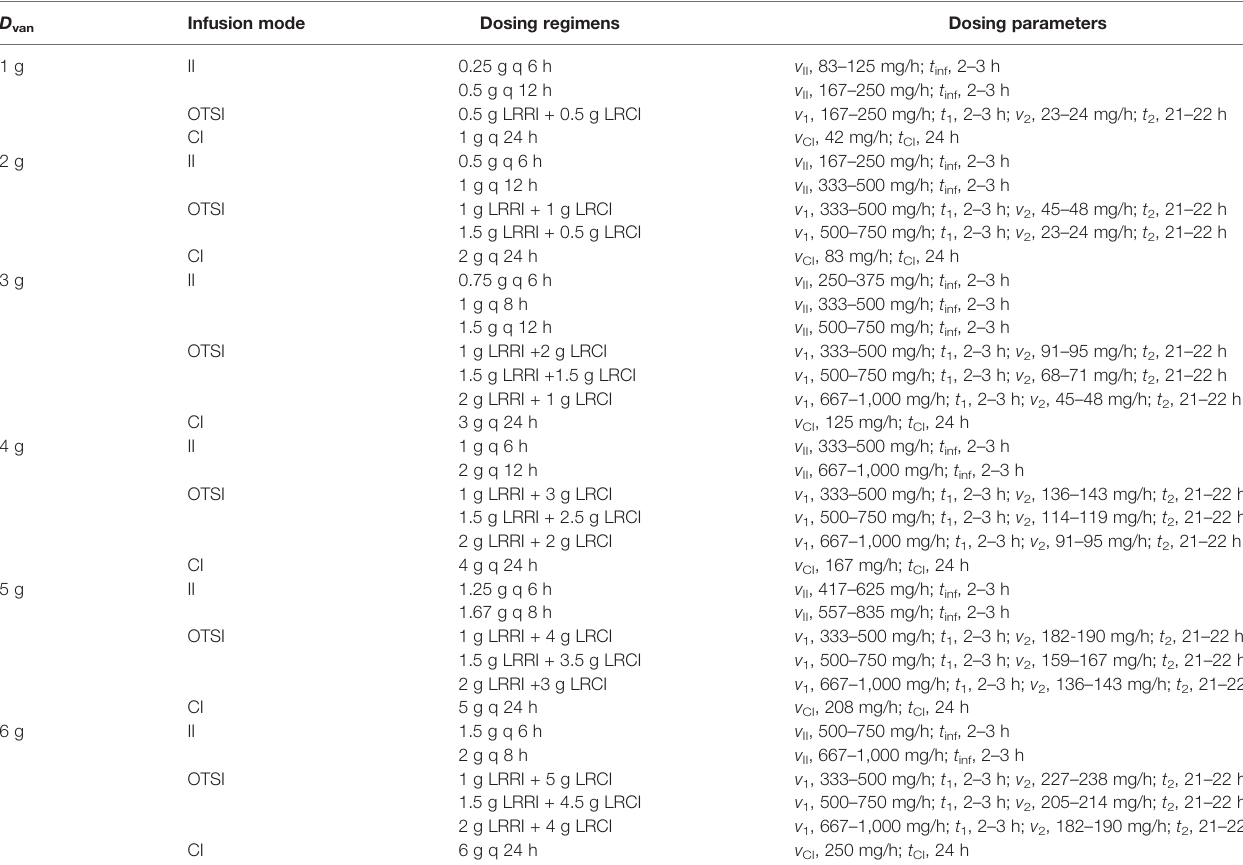
TABLE 1 | Thirty-four simulated dosage regimens and their dosing